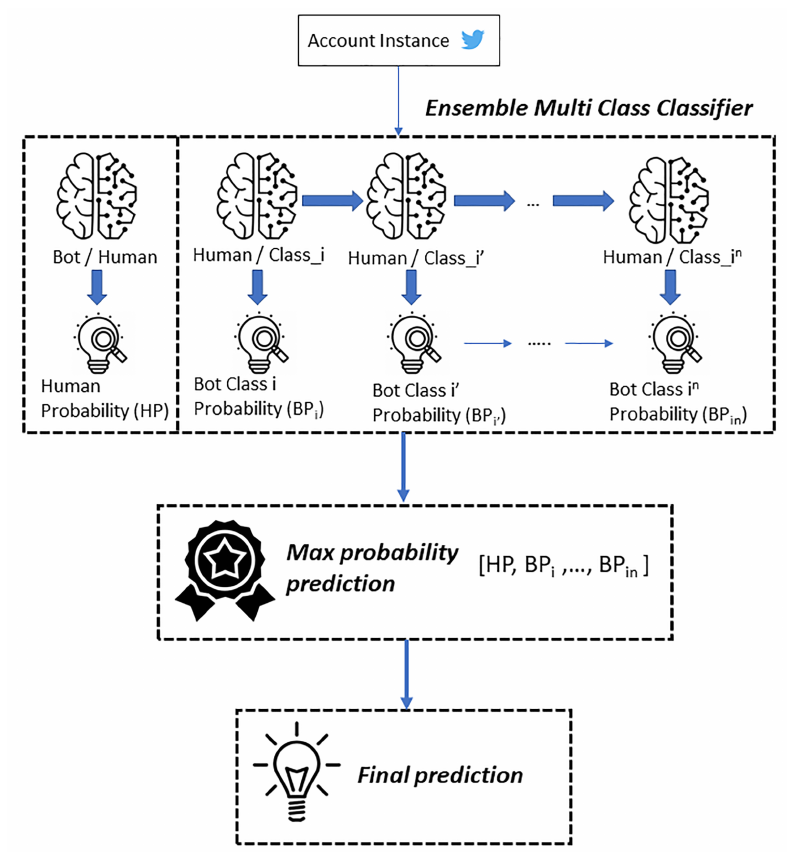
Figure 5. Multi-class Ensemble Execution